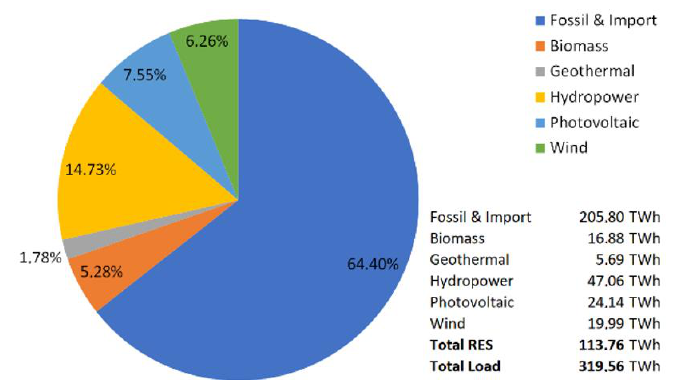
Figure 1. Energy mix for the electric energy supply in 2019.